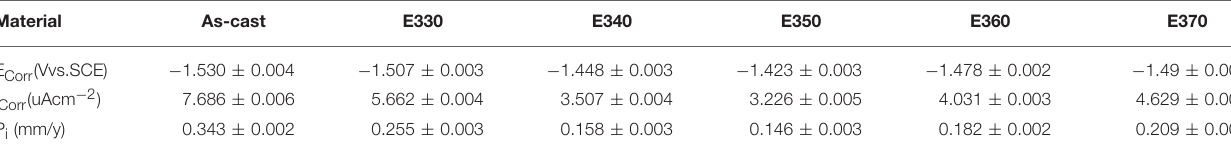
TABLE 3 | Values measured from potentiodynamic and P i of Mg-2.0Zn-0.5Zr-3.0Gd alloys. Material